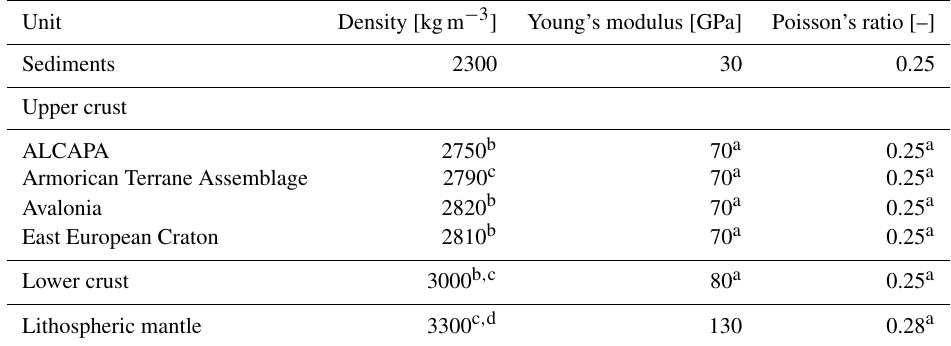
Table 2. Overview of the parameters used for the